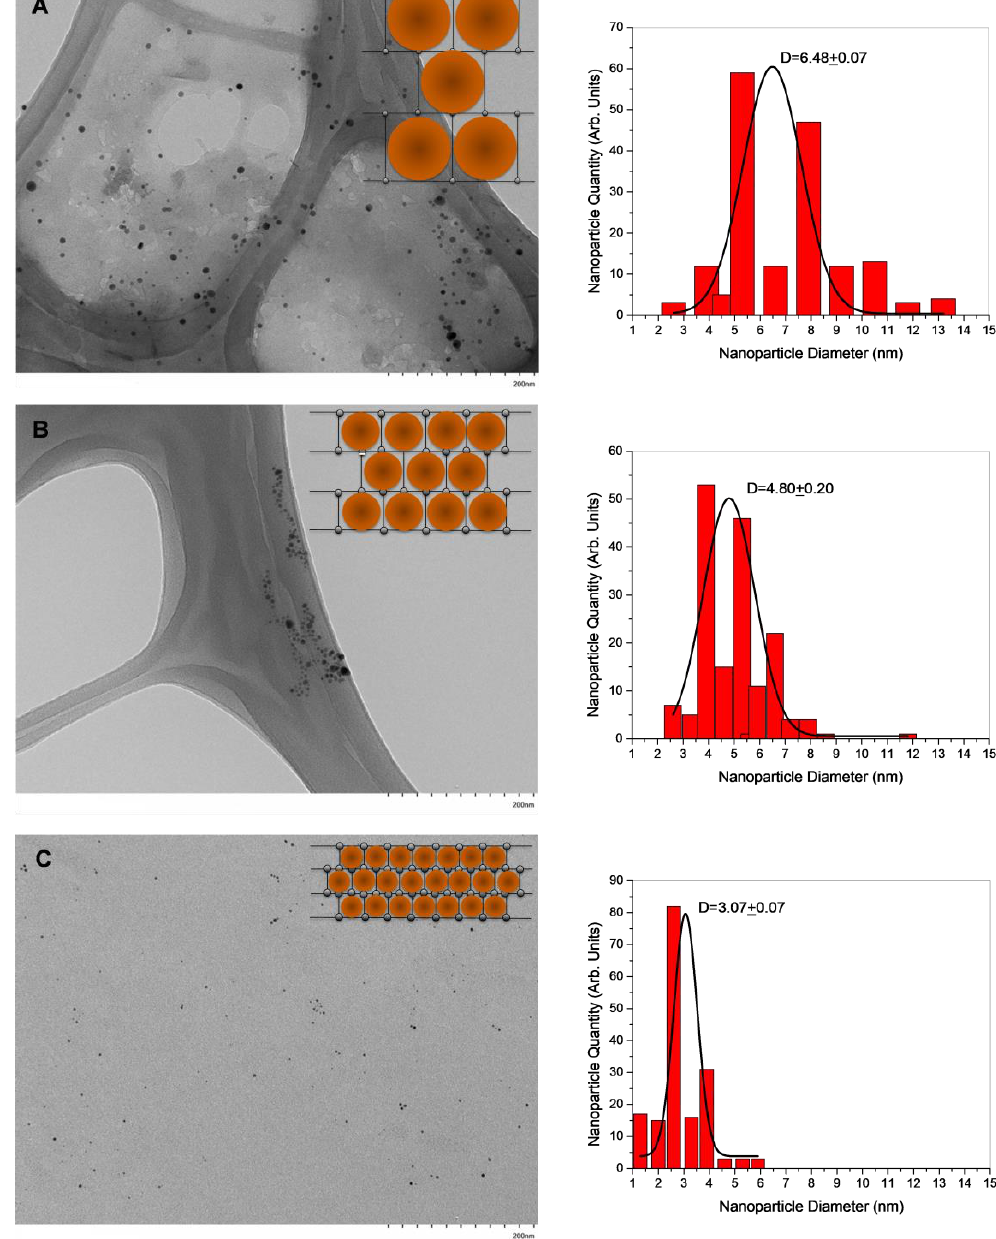
Figure 8. TEM images of ( A ) PMALH10-AgNPs, ( B ) PMALH20-AgNPs, and ( C ) PMALH30-AgNPs nanohybrids and their respective histogram.